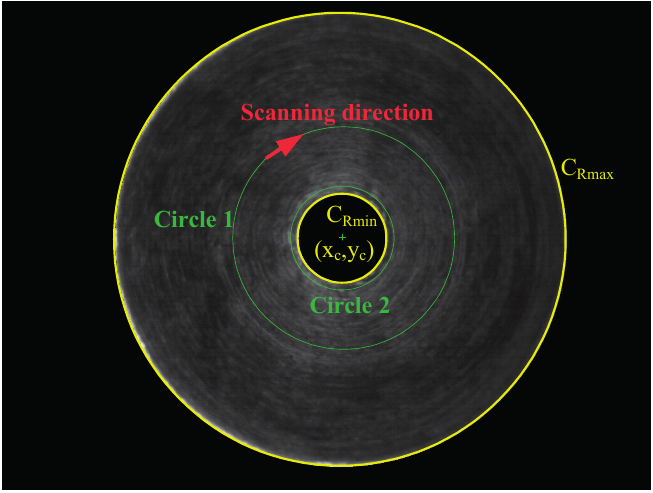
Figure 8. The scanning direction of the circle inspection for the ROI.